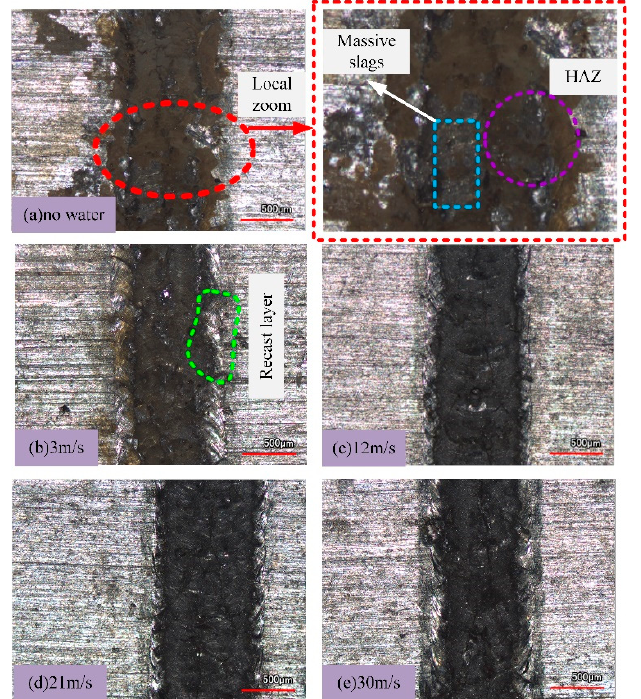
Figure 3. Groove width.